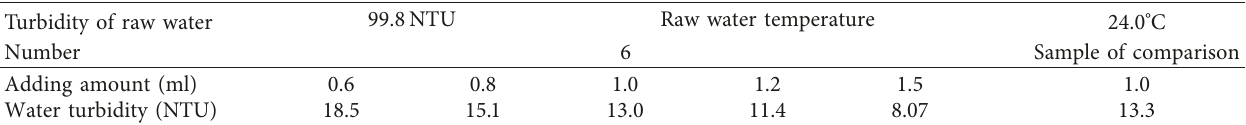
Table 8: Formula no. 6 treatment of tap water source water-related case.